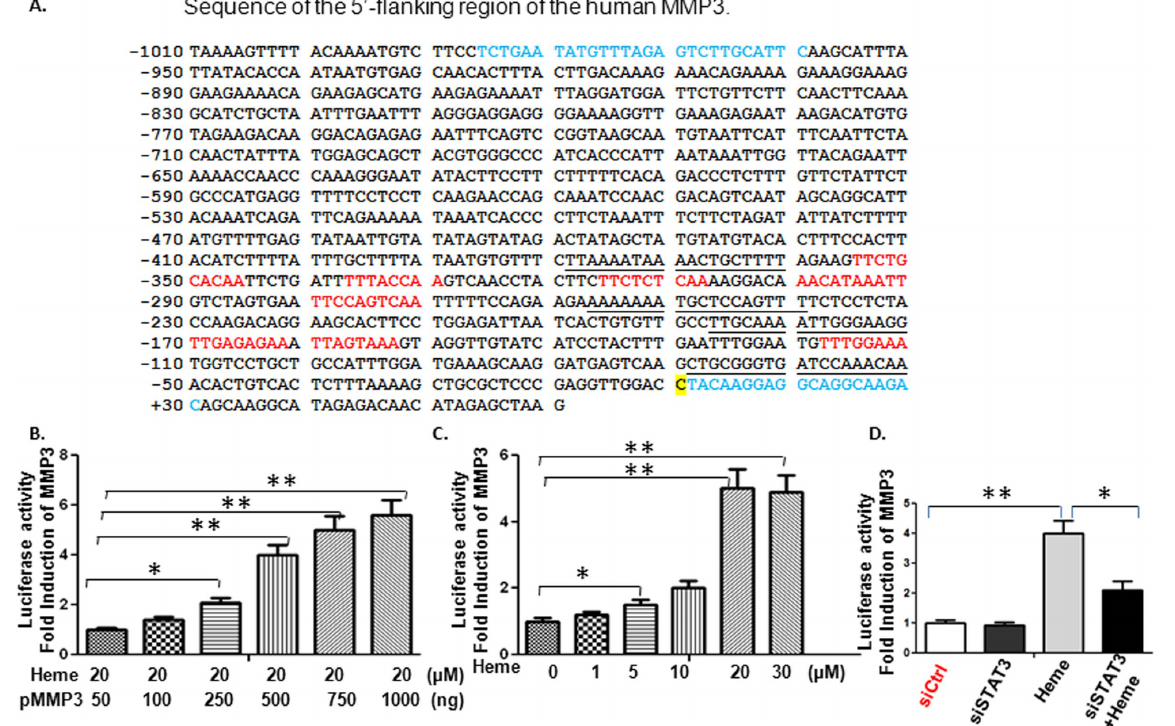
Figure 3. Heme induces MMP3 promoter activity in HBVEC cells. A, Sequence of the 5 9 -flanking region of the human MMP3 promoter. The primers used to generate MMP3 promoter fragment are shown in blue. The putative STAT3 binding sites, TT(N4–6)AA, are shown in red. Underlined sequences are the primers used to amplify the putative human STAT3 binding sites in MMP3 promoter region in ChIP assay. The ‘‘C’’ shaded in yellow denotes the transcription start site (TSS). To further delineate the transcriptional activity of MMP3 affected by STAT3, HBVEC cells were co-transfected with the MMP3 construct and STAT3-siRNA (siSTAT3) and incubated with Heme. The MMP3 promoter activity was proportional to amounts of MMP3 luc within the 50ng to 1000ng range when treated with Heme (Figure 3B). Figure 3C showed that Heme enhances the MMP3 promoter activity in a dose-dependent manner within a 5 m M to 30 m M range. As shown in Figure 3D, co-transfection with siSTAT3 significantly reduced the Heme-induced luciferase activity of